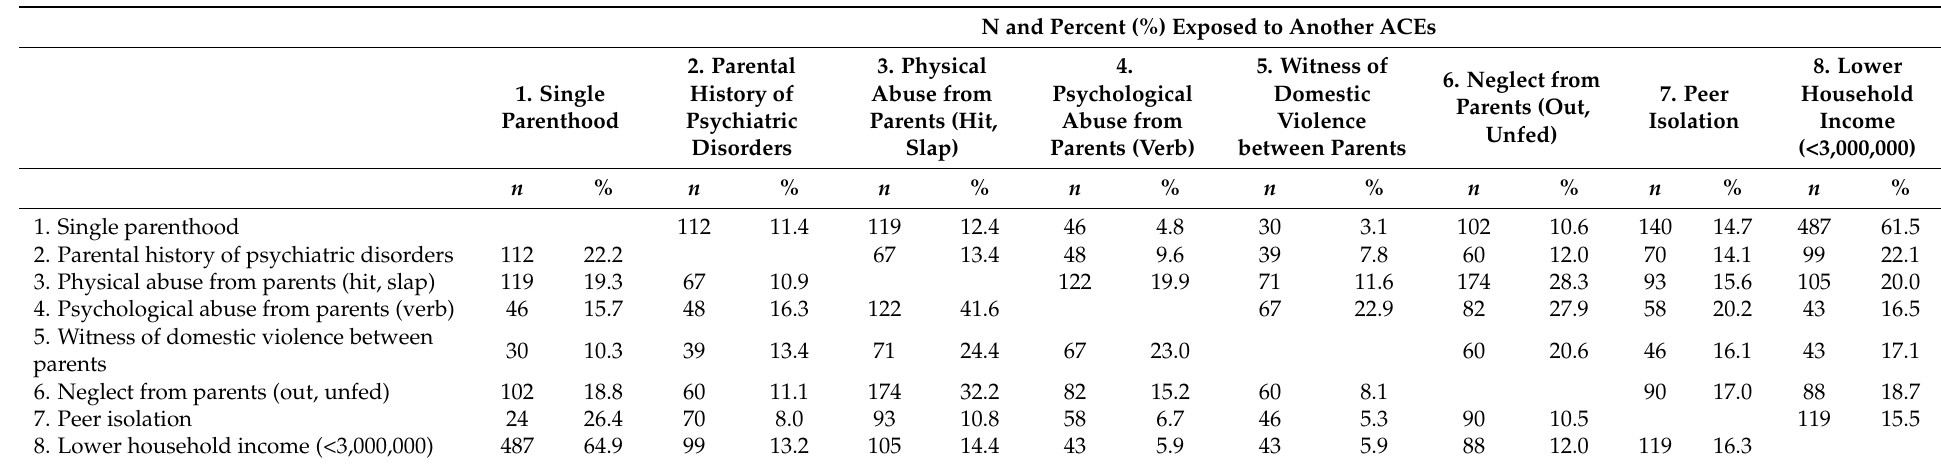
Table 3. Relationships between categories of adverse childhood experiences